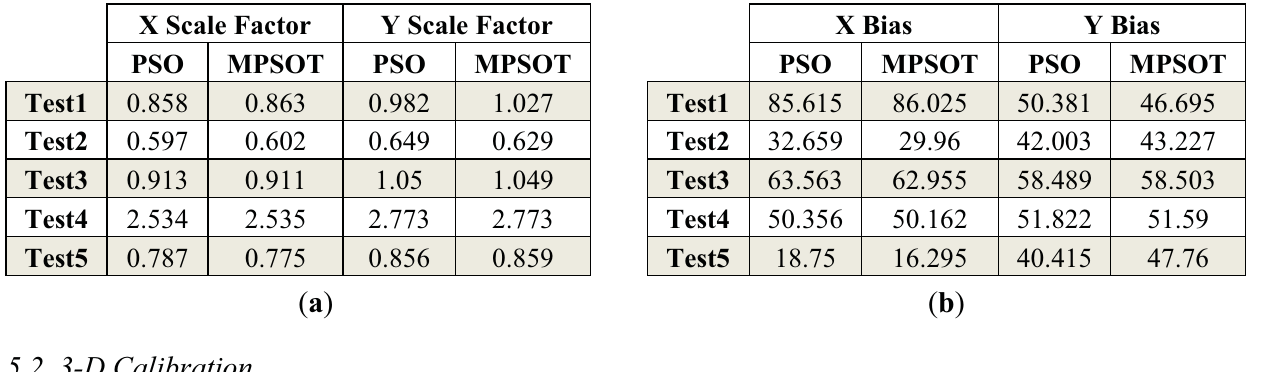
Table 2. Magnetometers parameters resulted from using the basic PSO and MPSOT in 2-D calibration. ( a ) Scale factor. ( b )